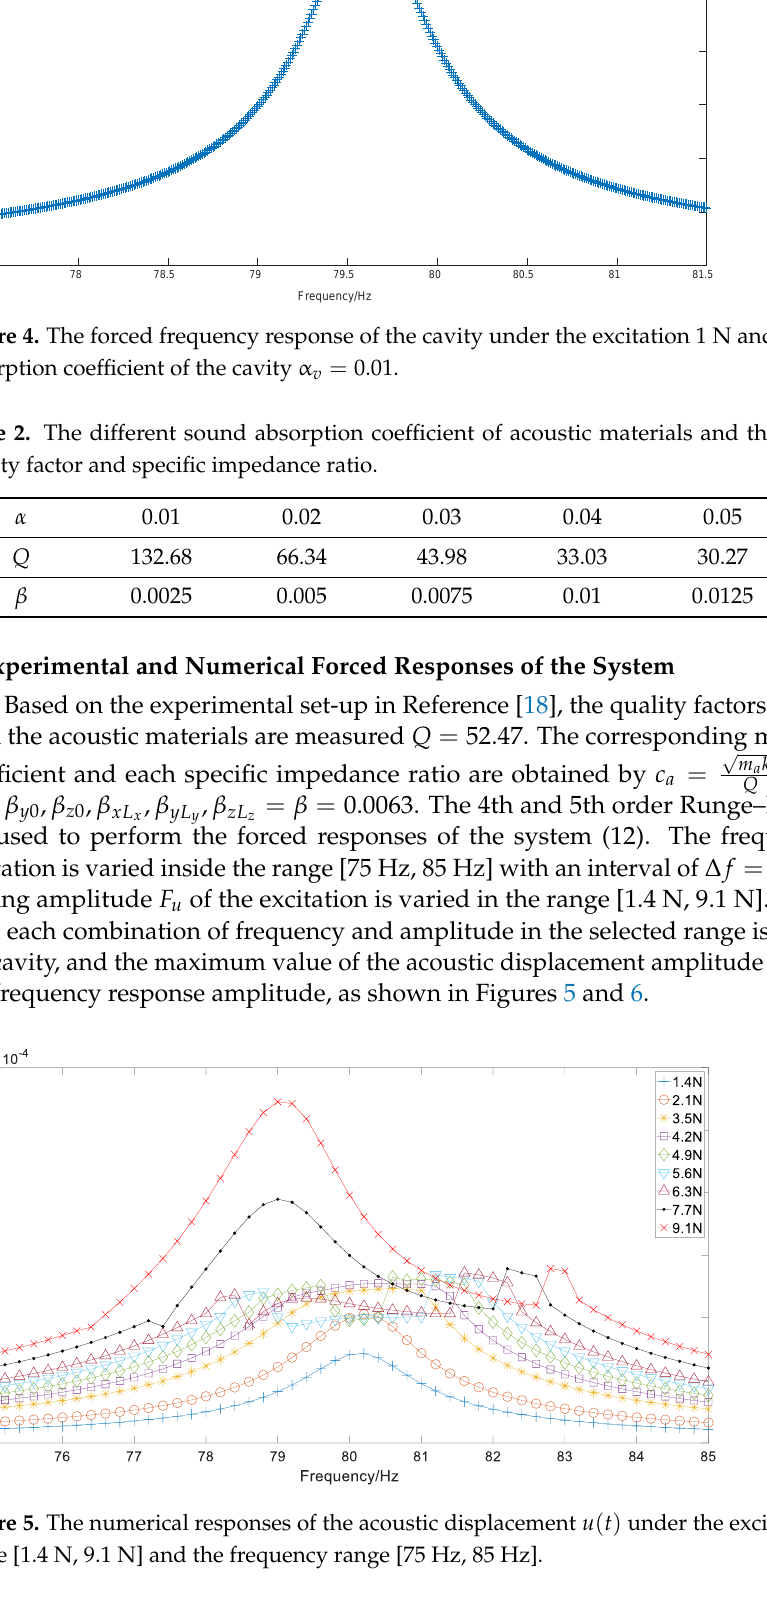
Figure 5. The numerical responses of the acoustic displacement 𝑢𝑢 ( 𝑡𝑡 ) under the excitation ampli- tude range [1.4 N, 9.1 N] and the frequency range [75 Hz, 85 Hz].